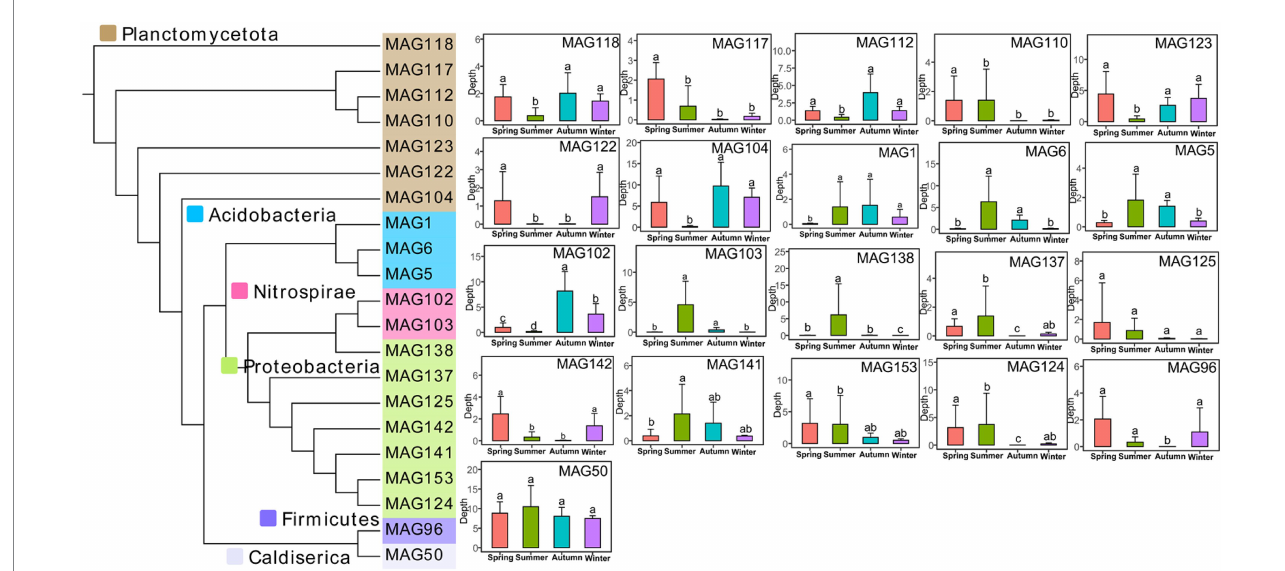
FIGURE 5 Phylogenetic tree of the recovered MAGs in nitrate reduction to ammonium and significant difference among the four seasons of each MAG. Different lowercase letters indicate significant differences among different seasons (Kruskal-Wallis test, p <